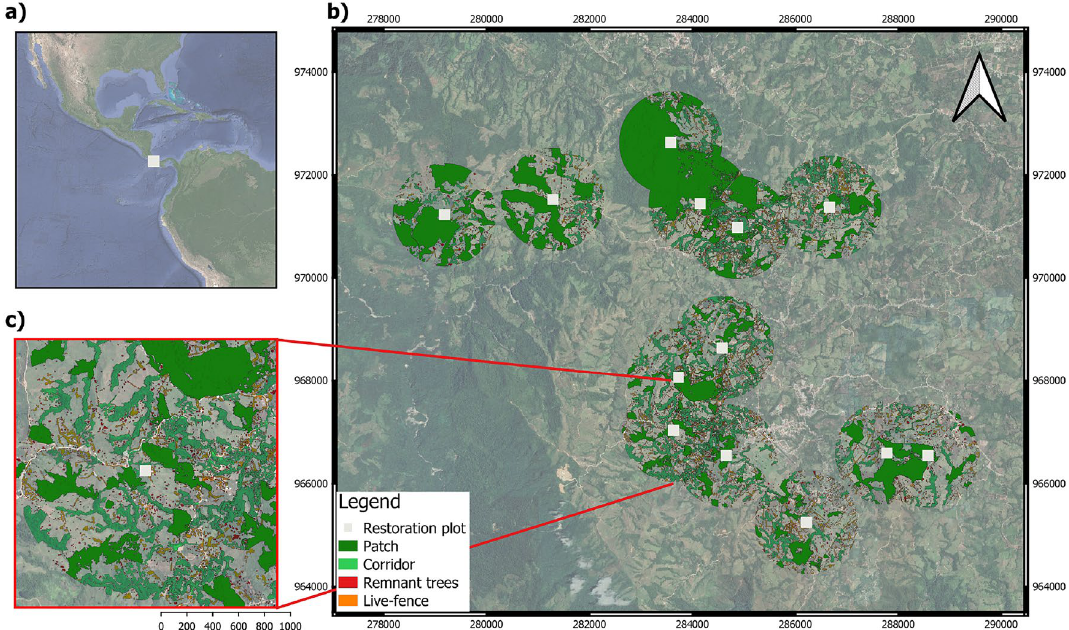
Figure 1. Location of the 13 focal restoration plots (white squares) and their respective surrounding landscape (900-m radius) in southern Costa Rica ( a , b ). We show in detail an example of one of these landscapes with its respective classified tree elements ( c ). Map created by MSJ with Quantum GIS v3.10.12 (https:// www. qgis.